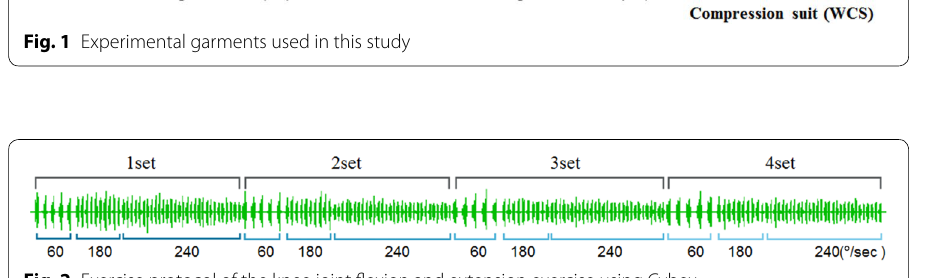
Fig. 2 Exercise protocol of the knee joint flexion and extension exercise using